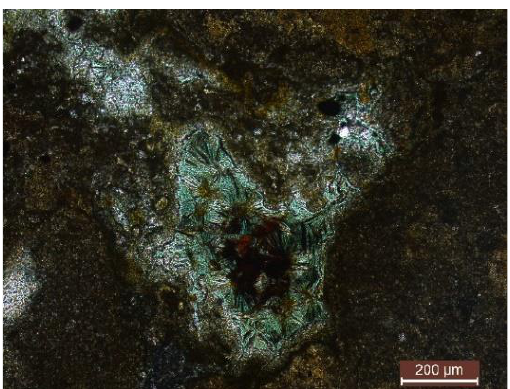
Figure 10. Chlorite filled in the shrinkage hole of tuff, Q9-3, 2175.43